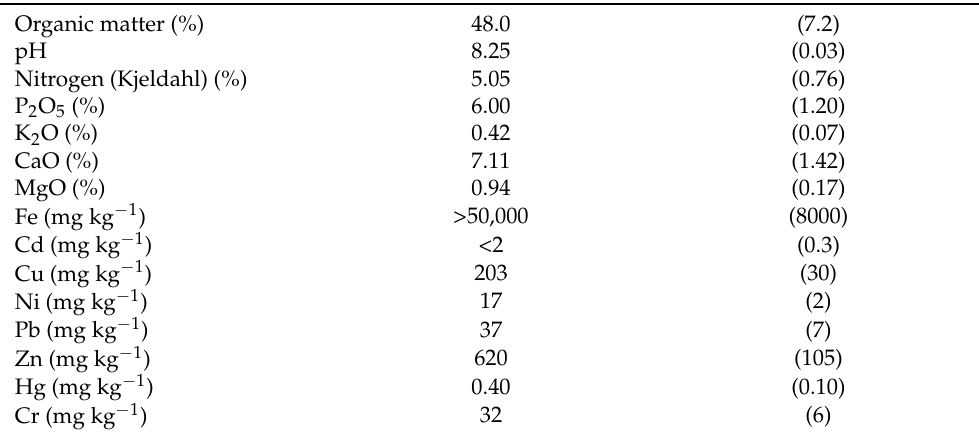
Table 2. Physico ‐ chemical properties of the sewage sludge sample (mean of four replicates). Standard deviations are given in parenthesis.